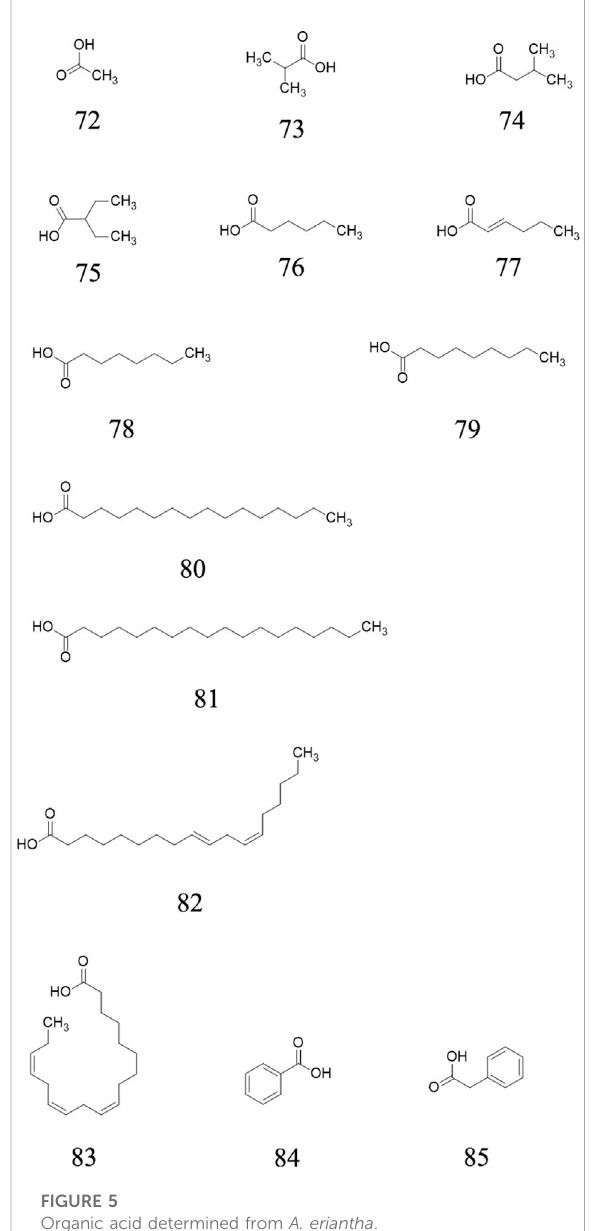
FIGURE 5 Organic acid determined from A. eriantha .